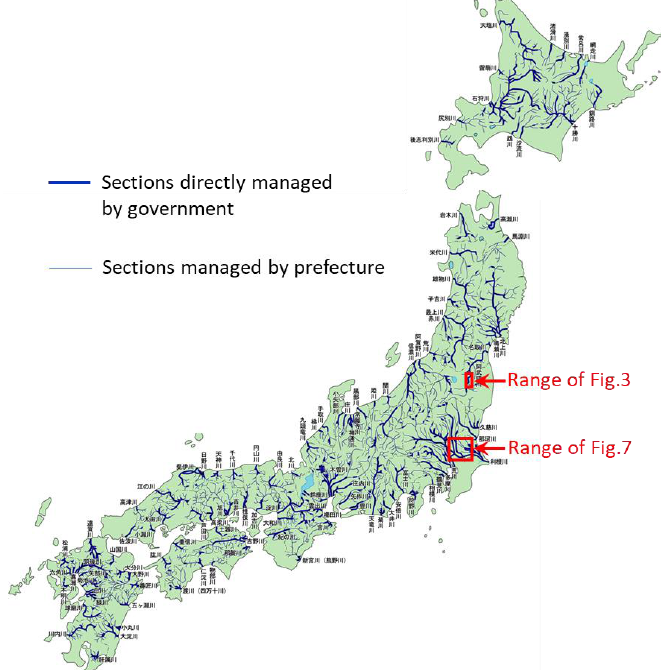
Figure 2. River channels of 109 first-class water systems in Japan.